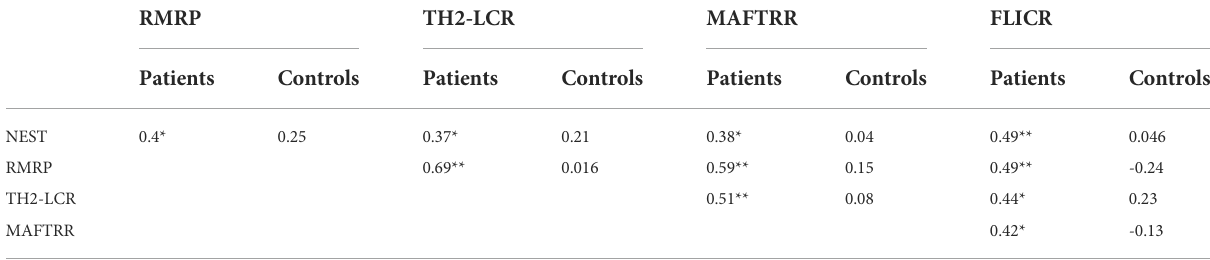
TABLE5Spearman ’ scorrelationbetweenexpressionlevelsoflncRNAsamongMSpatientsandhealthysubjects(* p -Valueatasigni fi cancelevelof p < 0.05.** p -Value at a signi fi cance level of p < 0.001). RMRP